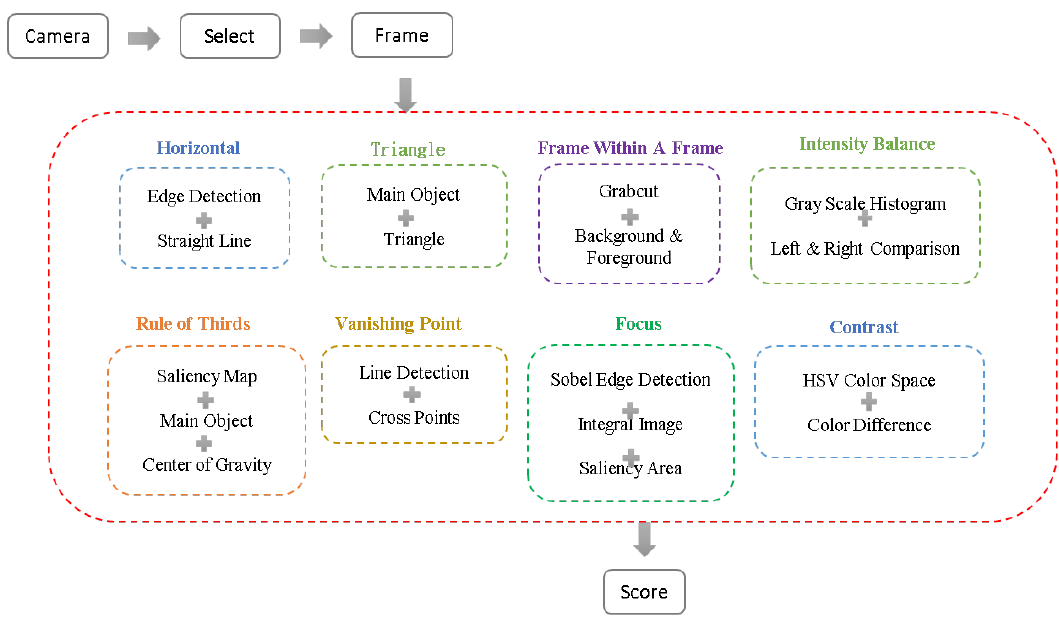
Figure 2. The system flow of this work.